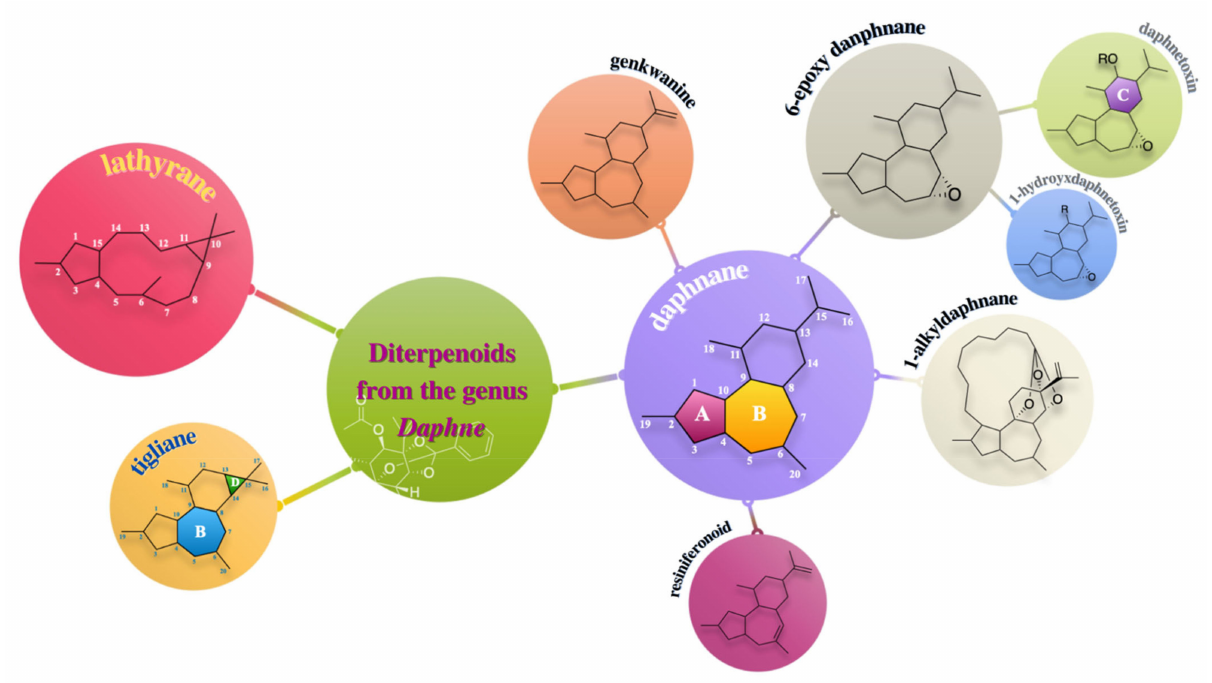
Figure 1. Classification and skeletons of diterpenoids from the genus Daphne